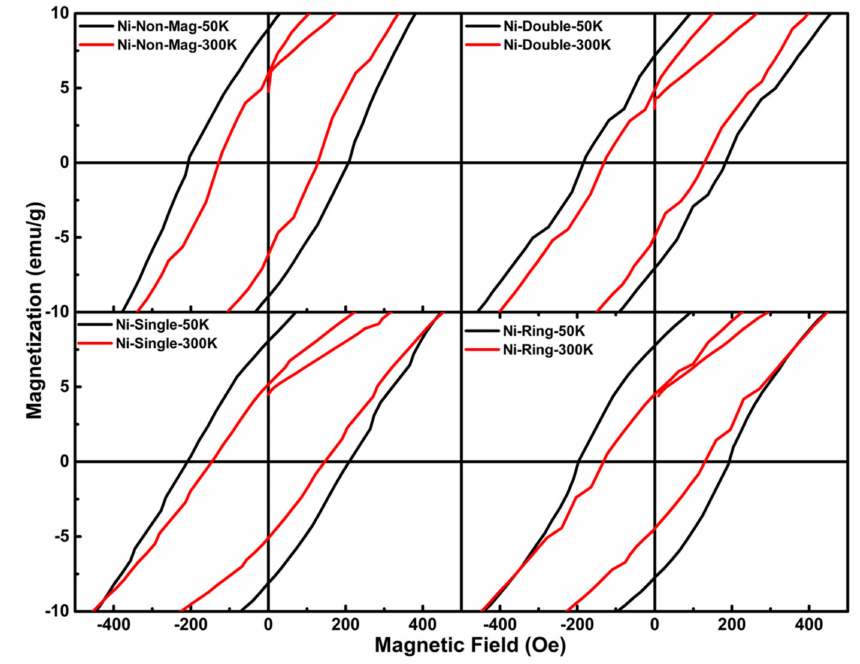
Figure 6. Comparison of MH hysteresis curves of each sample at temperatures of 300 K and 50